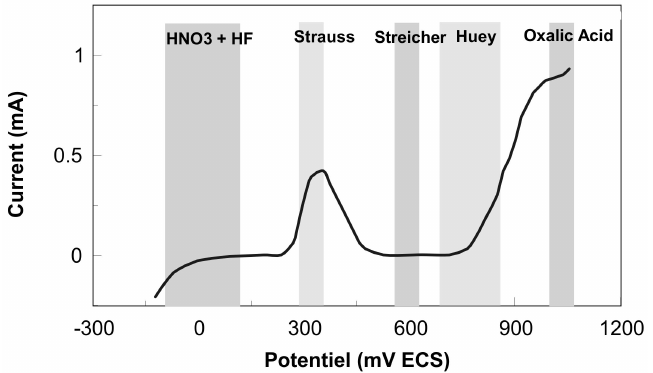
Figure 6. Corrosion potential corresponding to the various intergranular corrosion tests superim- posed on a polarization curve of a 304L austenitic steel in 1M H 2 SO 4